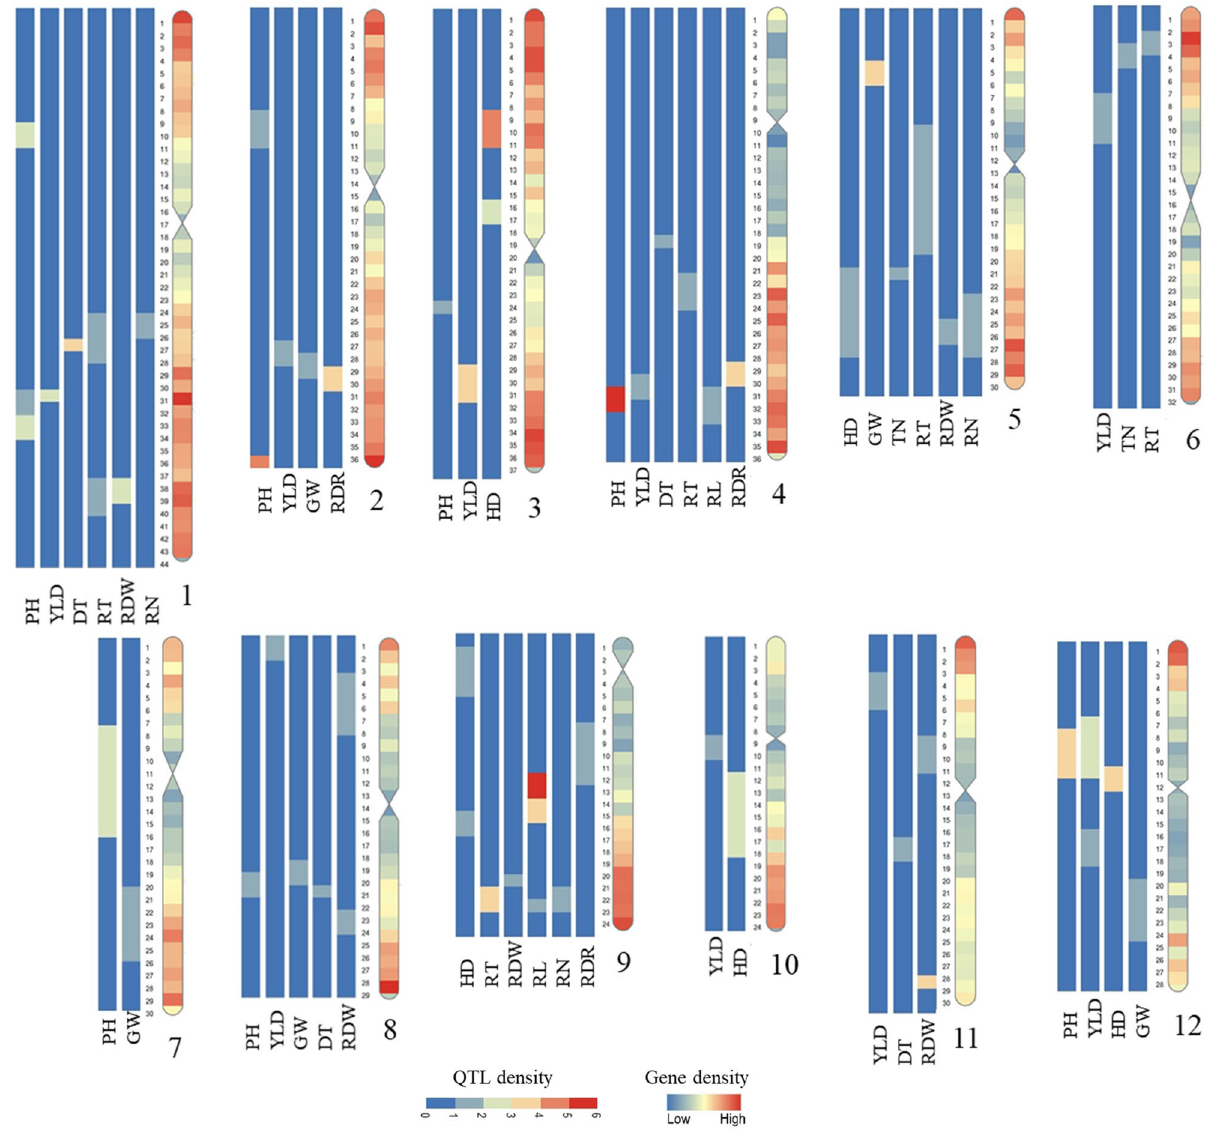
Figure 2. Heatmap of MQTLs for YLD, HD, PH, GW, TN, DT, RT, RL, RDR, RDW and RN presented on the rice genome in Mb. The gene density of each chromosome is indicated on the right